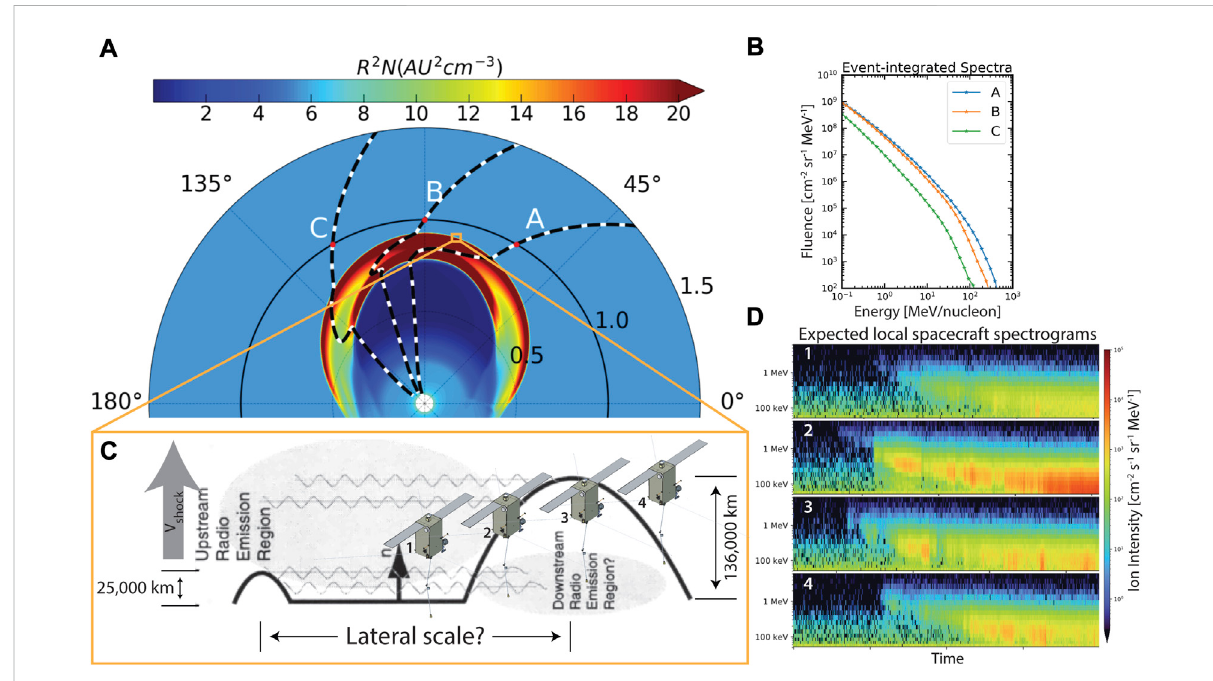
FIGURE 4 (A) Simulation of large-scale CME structure near 1 au yielding (B) longitudinal variations in event-integrated particle spectra. (C) Mesoscale structuring of a CME shock inferred from radio wave observations (adapted from Bale et al., 1999) with (D) potential observations from four spacecraft highlighting variations and impacts on particle dynamics. Mesoscale structuring of CMEs and effects on particle acceleration are poorly understood and cannot be addressed by previous, current, or planned